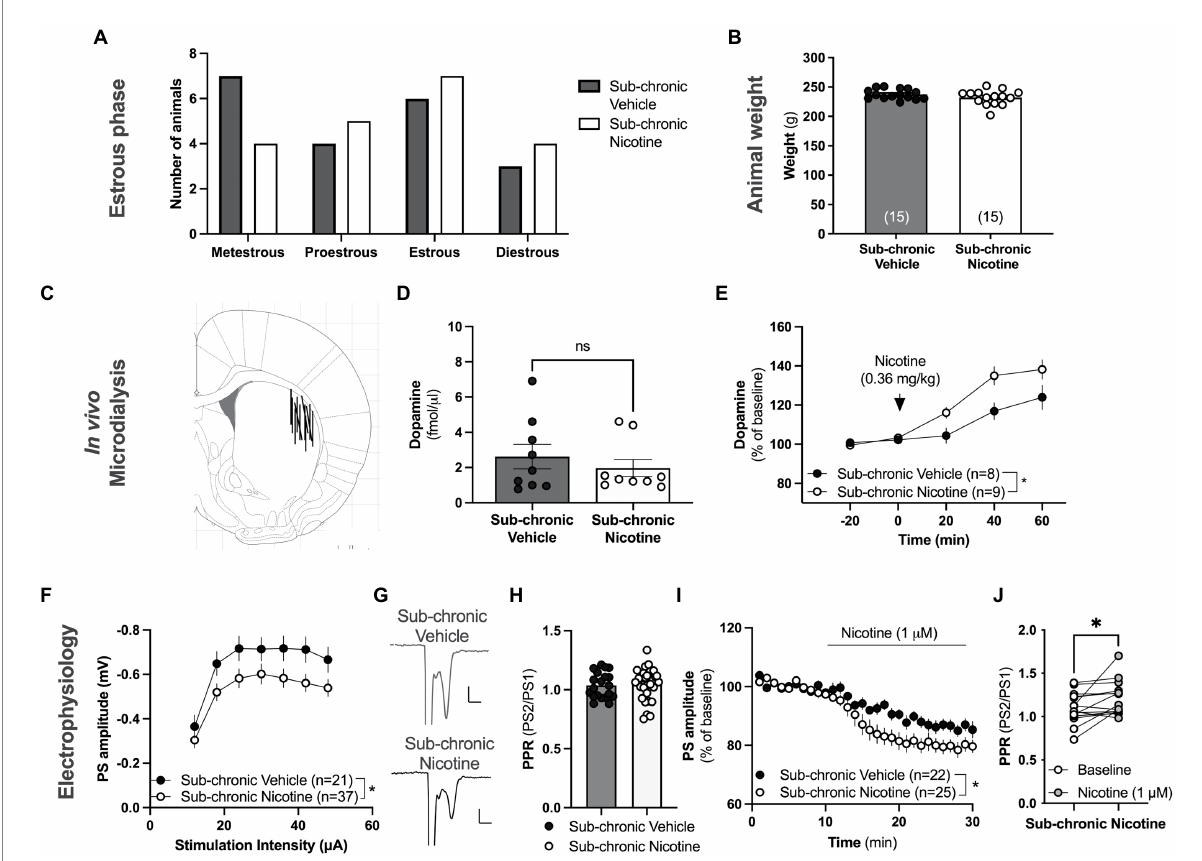
FIGURE 4 Neurophysiological transformations following sub-chronic nicotine exposure. (A) Estimated estrus phase based on vaginal smears for animals used during neurophysiological assessments. (B) Animal weight did not differ between treatment groups at the time point for neurophysiological assessments. (C) Schematic drawing showing the position of the active space of the microdialysis probe. (D) The microdialysate level of dopamine was not significantly altered by sub-chronic nicotine exposure. (E) Acute administration of nicotine, as indicated by the arrow, increased striatal dopamine to a significantly greater extent in animals receiving sub-chronic nicotine exposure. (F) Ex vivo electrophysiological recordings demonstrated that the amplitude of evoked potentials was significantly depressed in the DLS of animals previously receiving nicotine. (G) Example traces showing evoked PSs in a brain slice from a vehicle-treated rat (upper trace) and a rat receiving sub-chronic nicotine exposure (lower trace). (H) PPR was not significantly modulated by sub-chronic nicotine exposure. (I) Bath perfused nicotine depressed evoked potentials to a significantly greater extent in brain slices from rats receiving sub-chronic nicotine exposure. (J) Synaptic depression induced by acute nicotine exposure was accompanied by an increase in PPR, indicating that nicotine reduces the probability of transmitter release. Data are mean values ± SEM. n = number of animals in (B,E) , and number of slices in (F,I) . Slices were taken from at least five animals/treatment. * p < 0.05, ** p <